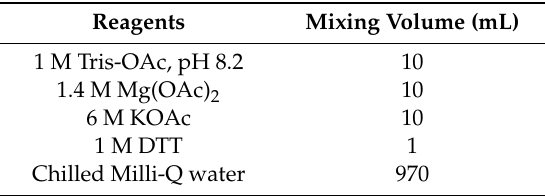
Table 1. The components for 1 L of buffer